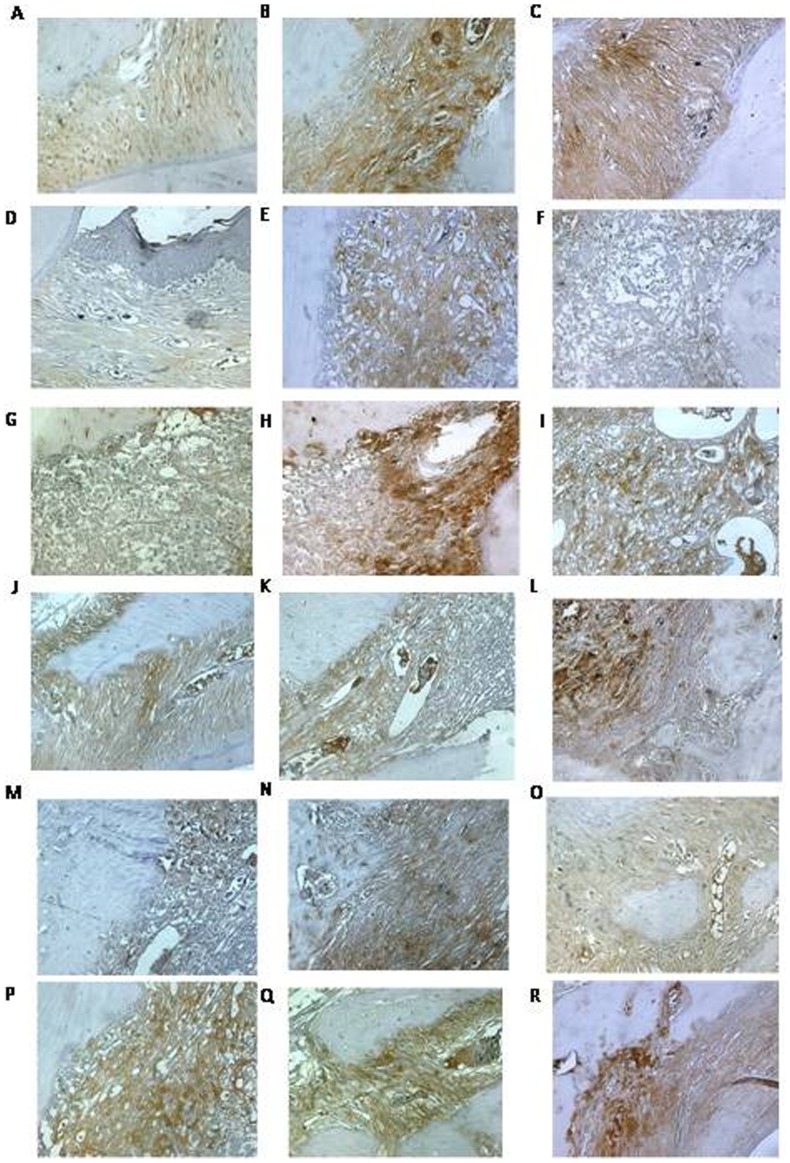
Histological analyses of (A–C) MMP-2, (D-F) MMP-9, (G–I) COX-2, (J–L) RANK, (M–O) RANK-L, and (P–R) OPG in periodontal tissue of rats with periodontal disease.Rats subjected to saline are pictured in A, D, G, J, M, P; rats with periodontal disease are pictured in B, E, H, K, N, Q; rats with periodontal disease and treated with Atorvastatin (10 mg/kg) are pictured in C, F, I, L, O, R. 100× magnification, bar scale = 100 µm.